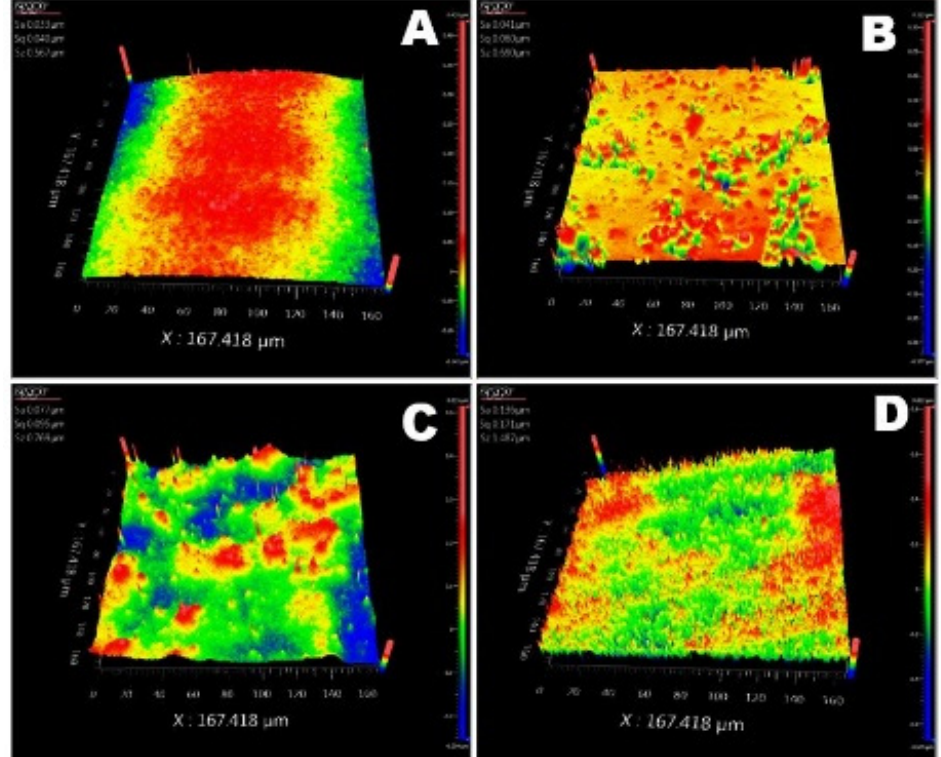
Figure 4. Surface topography analysis of the prepared pristine CTA and CTA with different concen- trations of CeO 2 nanoparticles: ( A ) CTA, ( B ) CTA-CeO 2 (0.32), ( C ) CTA-CeO 2 (0.64) and ( D ) CTA- CeO 2 (0.9). Table 2. Glass transition temperature, mechanical properties and surface roughness comparison of the synthesized mem- branes.